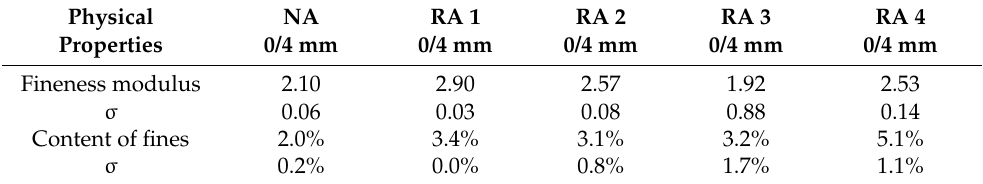
Table 2. Basic physical properties.